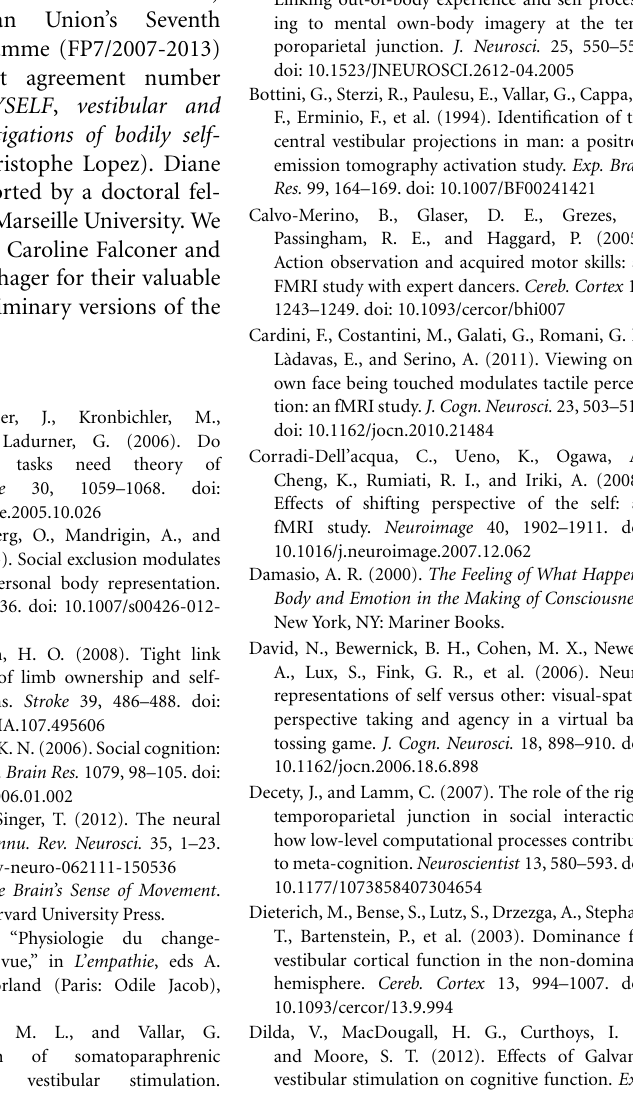
illusory self-attribution of a non-corporeal object. Adapted from Tsakiris et al. (2008). (C) Temporo-parietal region involved in egocentric mental rotation tasks. Reproduced from Blanke et al. (2005). (D,E) Brain regions involved in theory of mind and empathy. Reproduced from Decety and Lamm